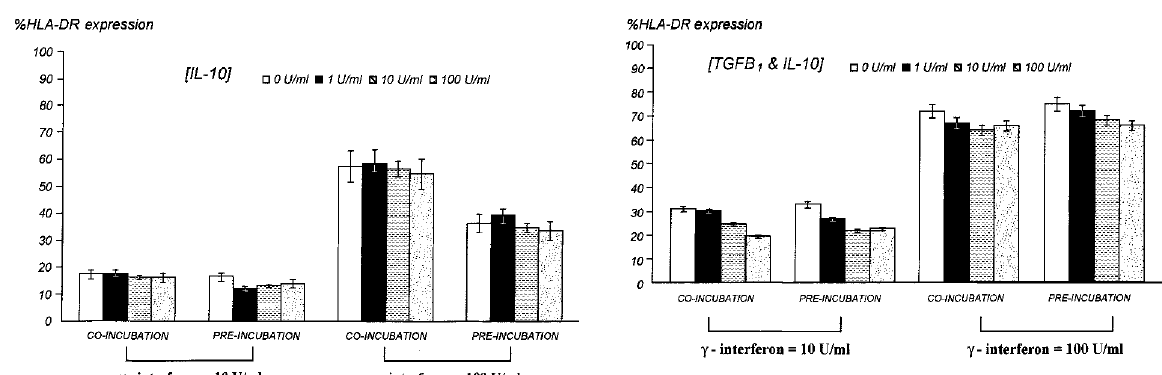
FIG. 3. The effect of combination interleukin-10 and trans- forming growth factor g -1 on g -interferon induced HLA-DR expression. (The error bars represent ±1 standard deviation.) * P -value for ANOVA